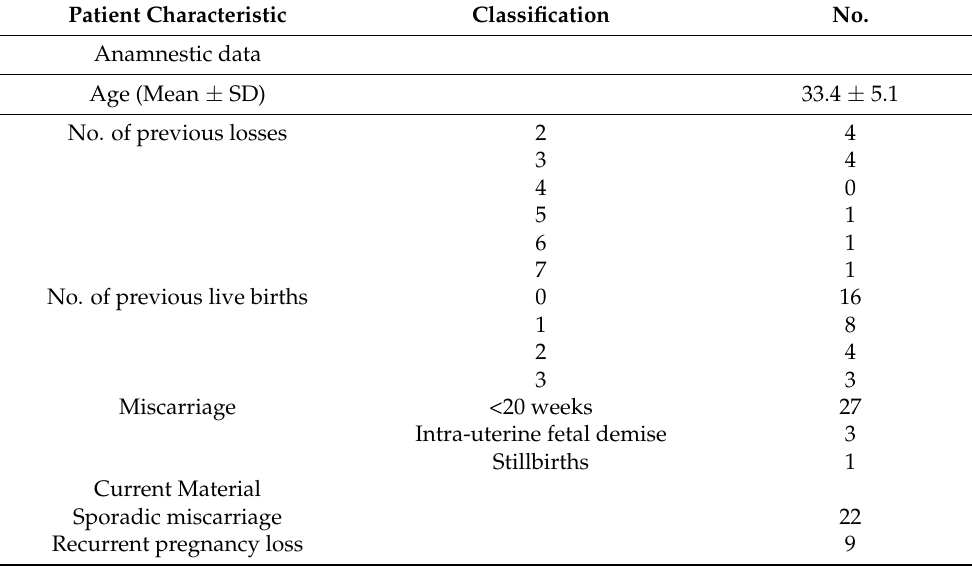
Table 1. Clinical